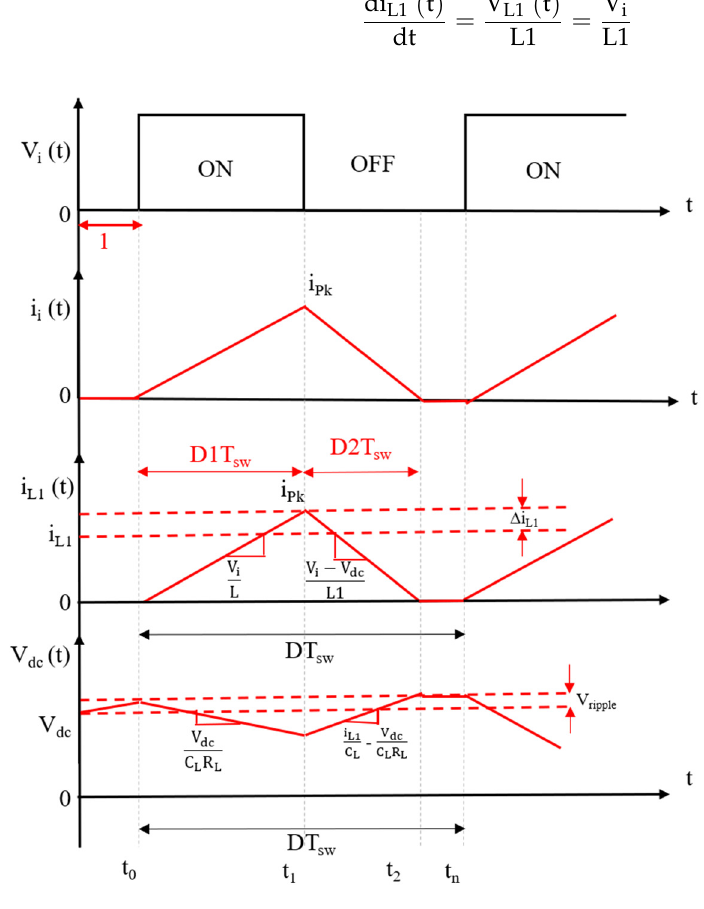
Figure 8. Waveforms of the proposed circuit when switching signals are applied in positive half cycles.